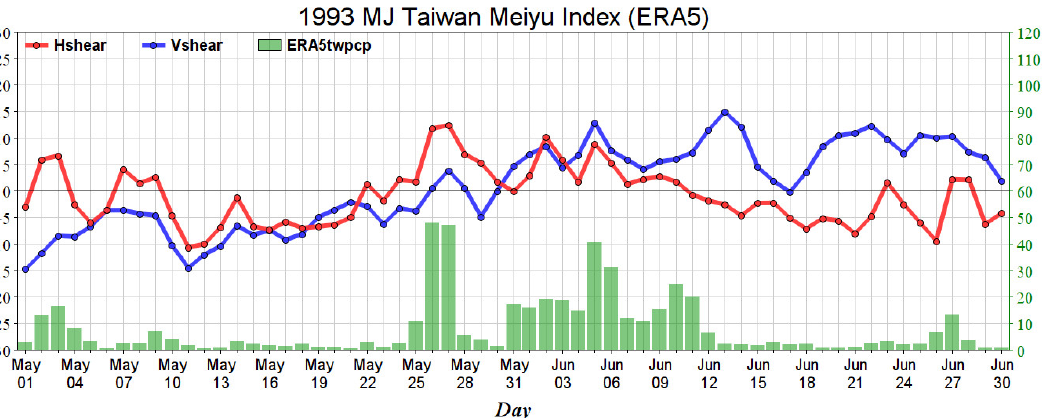
Figure 7. Time-series of Meiyu index and precipitation over Taiwan from 1 May to 30 June in 1993. The Meiyu index consists of Hshear (red line) and Vshear (bue line) and ERA5twpcp in Taiwan (green bar).